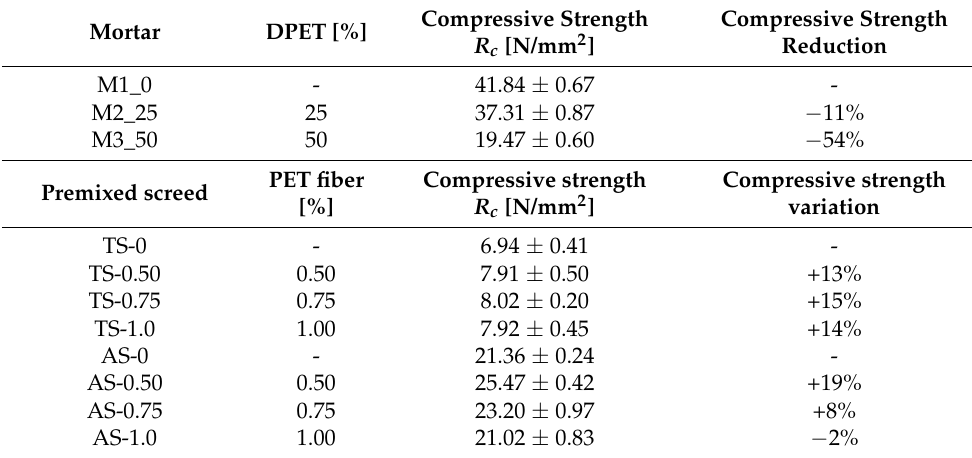
Table 5. Compressive strength results with deviation standard values of all tested specimens contain- ing recycled